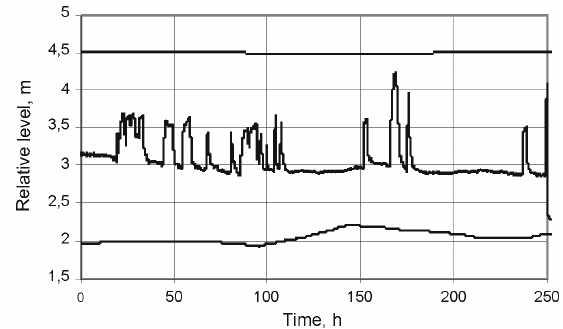
Fig. 3. Level hydrographs of the Nemunas river for cross- sections at Nemajunai (top), km upstream from Kaunas HPP, in downstream reach of the HPP (middle) and for cross-section at Smalininkai (bottom), km downstream the HPP. Zero time is 2004 09 20 12 00; actual absolute alti- tudes of top curve are larger by 46.20 m, middle – 17.10 m, bottom – 6.00 m